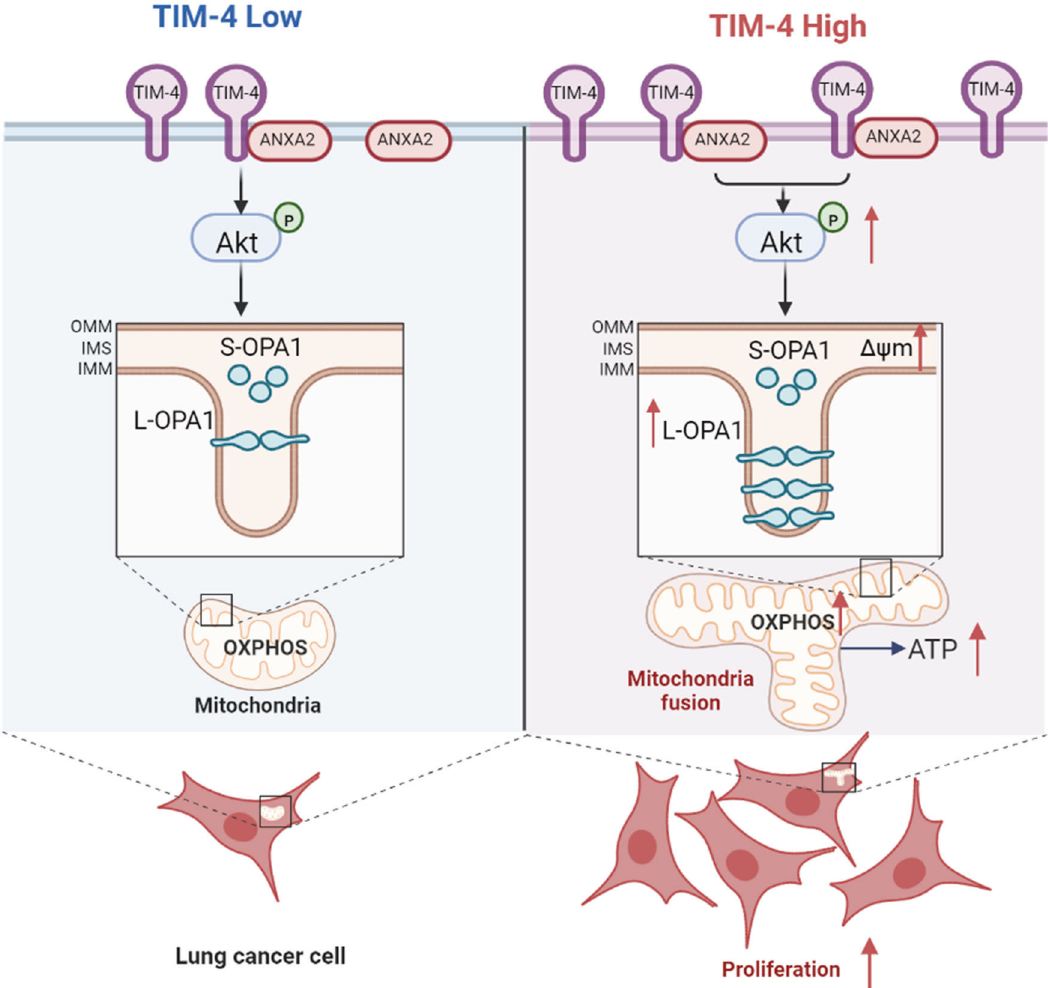
Fig. 7 Schematic illustration for TIM-4 orchestrating mitochondrial homeostasis via ANXA2/PI3K/AKT/OPA1 axis in lung cancer. TIM-4 interacts with ANXA2 to activate PI3K/AKT signaling and promotes L-OPA1 expression. When TIM-4 expression is elevated, AKT activation is enhanced to maintain L-OPA1 levels and enhance mitochondrial fi tness. The maintenance of L-OPA1 leads to a more fusion state of mitochondria, which leads to increased OXPHOS levels, thus promoting lung cancer cell